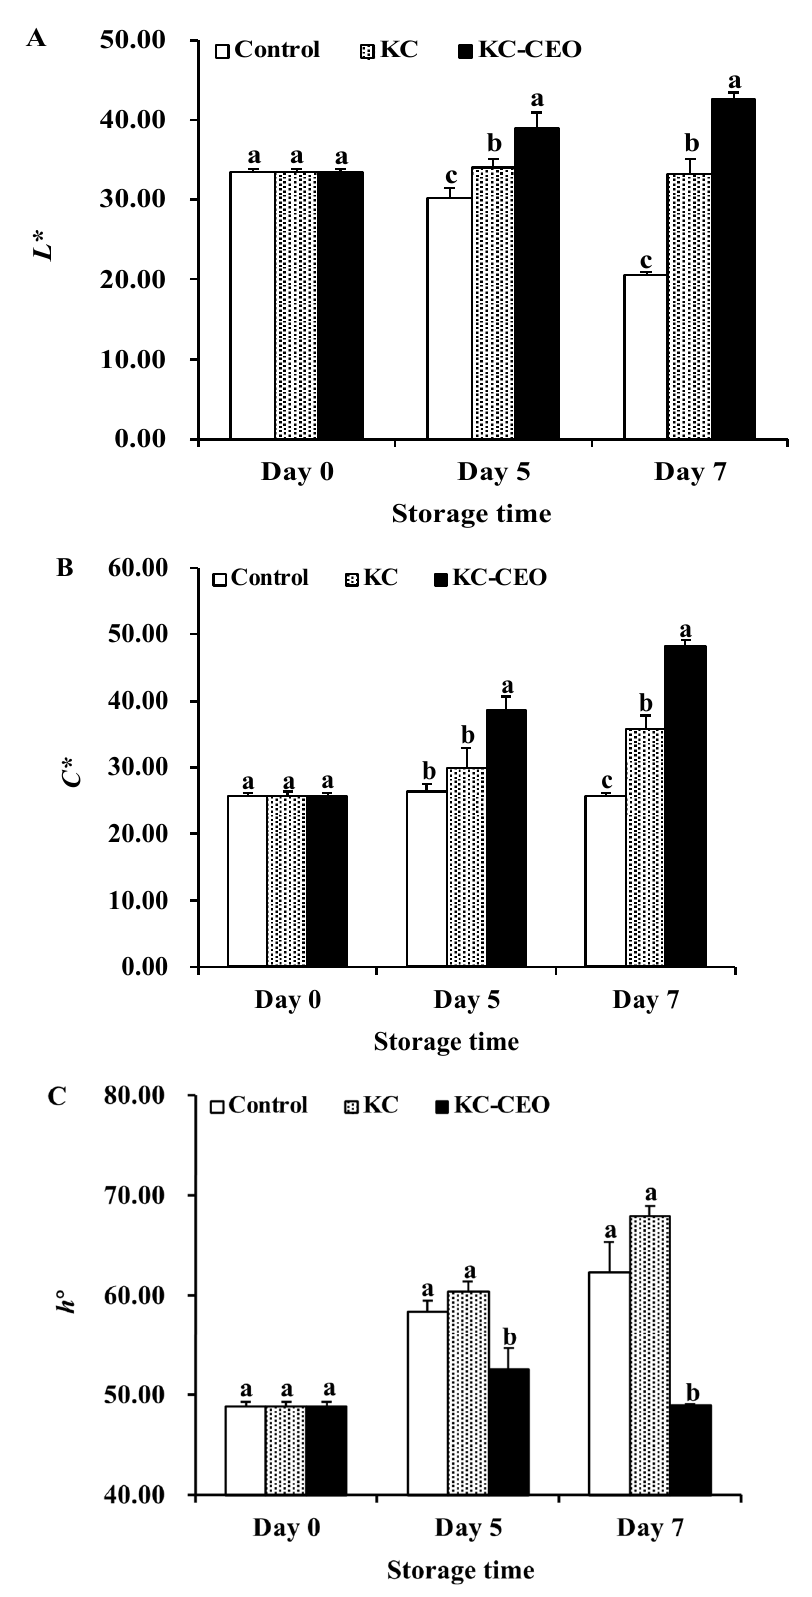
Figure 6. Impact of KC-based coatings on the color parameter of L* ( A ), C* ( B ), and h ◦ ( C ) in pork meat during refrigerated storage (4 ◦ C). KC, kappa-carrageenan; CEO, cinnamon essential oil. Different letters for data points on each day represent significant differences ( p < 0.05).